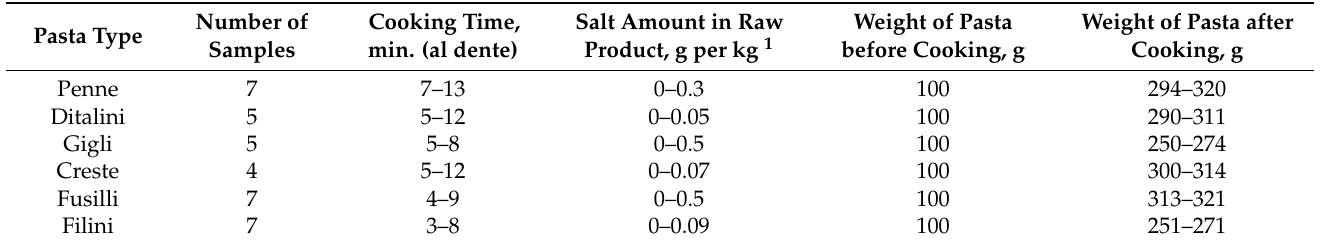
Table 1. Characteristics of analysed